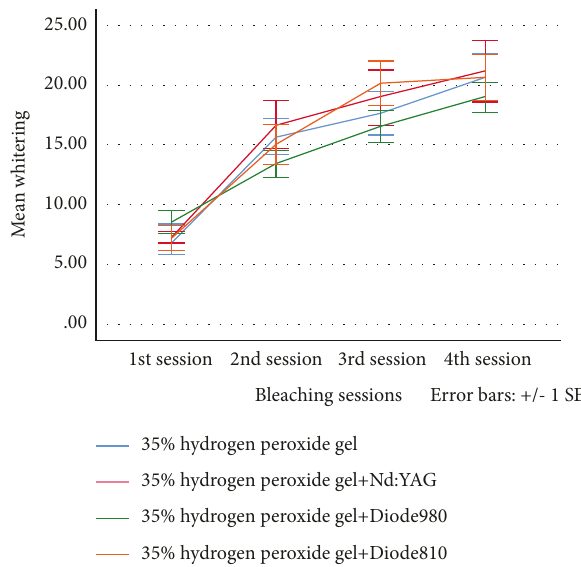
Figure 1: Mean whitening measures after each bleaching